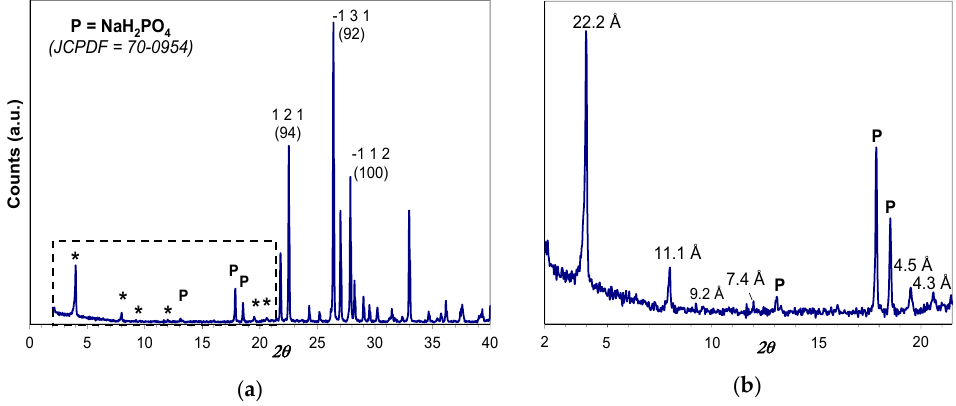
Figure 2. XRD patterns of the NaH 2 PO 4 -based C12GA xerogel: ( a ) overall pattern; and ( b ) magnification of the low-angle region marked with the dashed rectangle. The peaks labelled with an asterisk correspond to the periodical arrangement of C12GA gelator molecules (the distances are shown in the magnification), and all the remaining peaks correspond to NaH 2 PO 4 phase (monoclinic P21/c space group, JCPDF number 70-0954) marked as P only in the low angle region; the Miller indexes and theoretical relative intensities of the three most intense peaks of NaH 2 PO 4 are indicated. Noteworthy, several and relatively intense diffraction peaks may be also observed in the low- angle region below 20° 2 θ (marked with and asterisk), which are associated with the long-range ordering or periodic packing (3D self-assembly) of C12GA gelator molecules in the nanofibrous hydrogel. The main and sharper peaks at lower angles around 4° and 8° 2 θ correspond to d spacings of 22.2 and 11.1 Å, respectively, which fit very nicely with the whole and half calculated distances for an extended C12GA gelator molecule, and the less intense peak around 12° 2 θ (7.4 Å spacing) might be also assigned to the third order diffraction of this 22.2 Å distance. Additionally, other relevant peaks of lower intensity are observed at wider angles corresponding to 4.5 and 4.3 Å spacings (and also to 9.2 Å, with a much lower intensity), which could be ascribed to the two-dimensional packing of sheet-like structures. A proposed packing or aggregation model for C12GA molecules in the self- assembled (phosphorylated) hydrogel is later discussed (see Section 2.1.3), in accordance with the features observed in this low-angle region of the WAXD pattern.